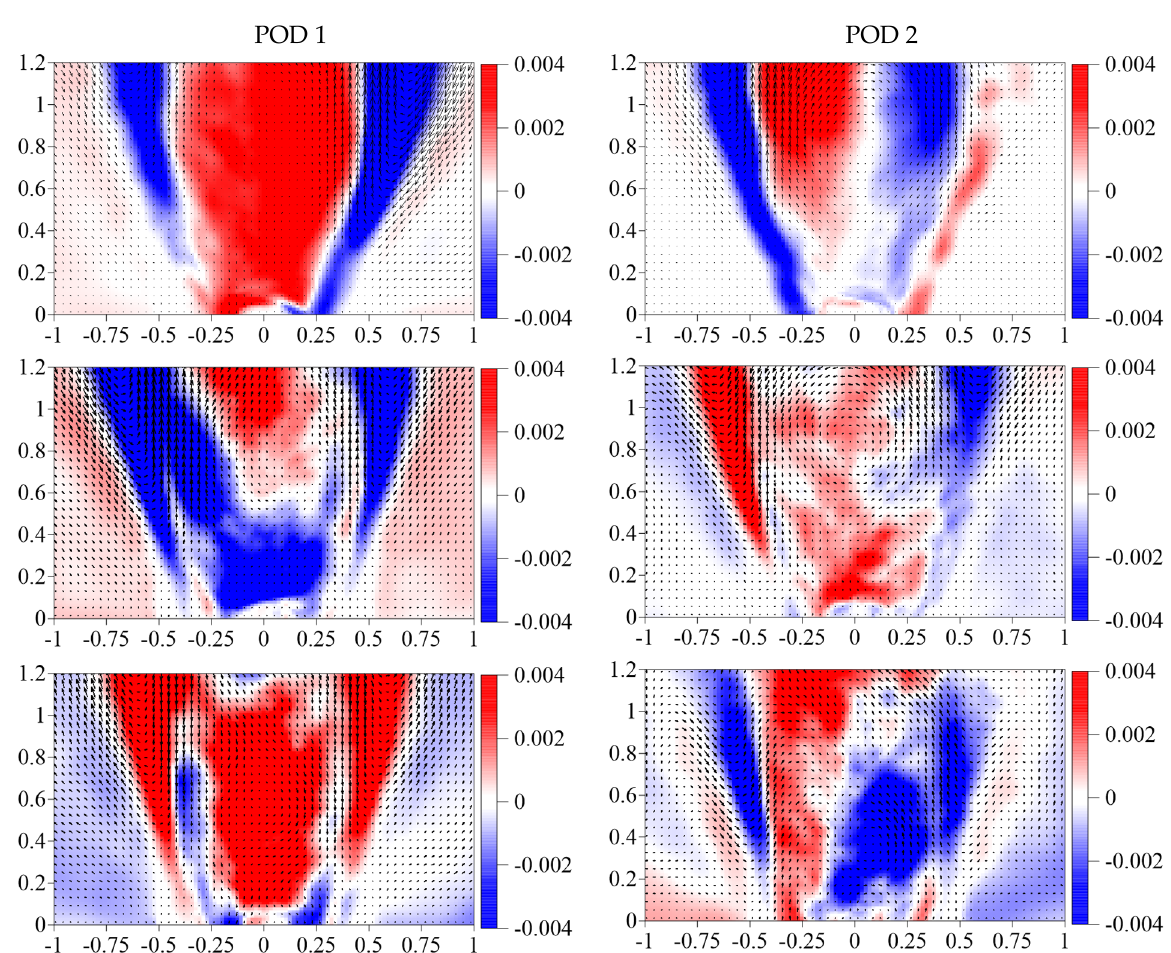
Figure 14. The first and the second POD modes with the conditionally sampled CO 2 concentration: the first line—1 atm. 293 K; the second line—2 atm. 500 K; the third line—3.4 atm. 500 K.